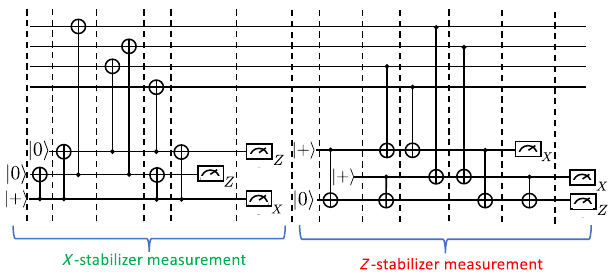
FIG. 7. Circuit for the measurement of the X stabilizers followed by the Z stabilizers of the heavy-square